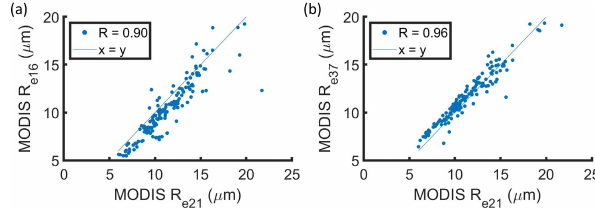
Figure 6. (a) R e16 and (b) R e37 as functions of R e21 for MODIS retrievals co-located with in situ data for (cid:49)T less than 3600s. Each point represents average values over a 5 × 5 pixel domain.